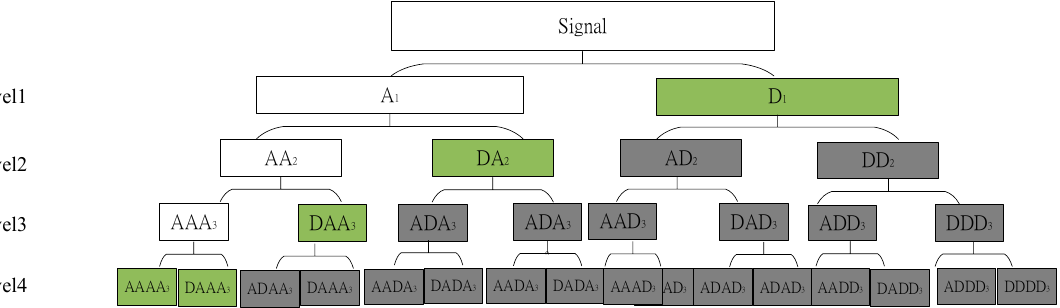
Figure 6. Schema of fast optimal wavelet basis (OWB) algorithm.